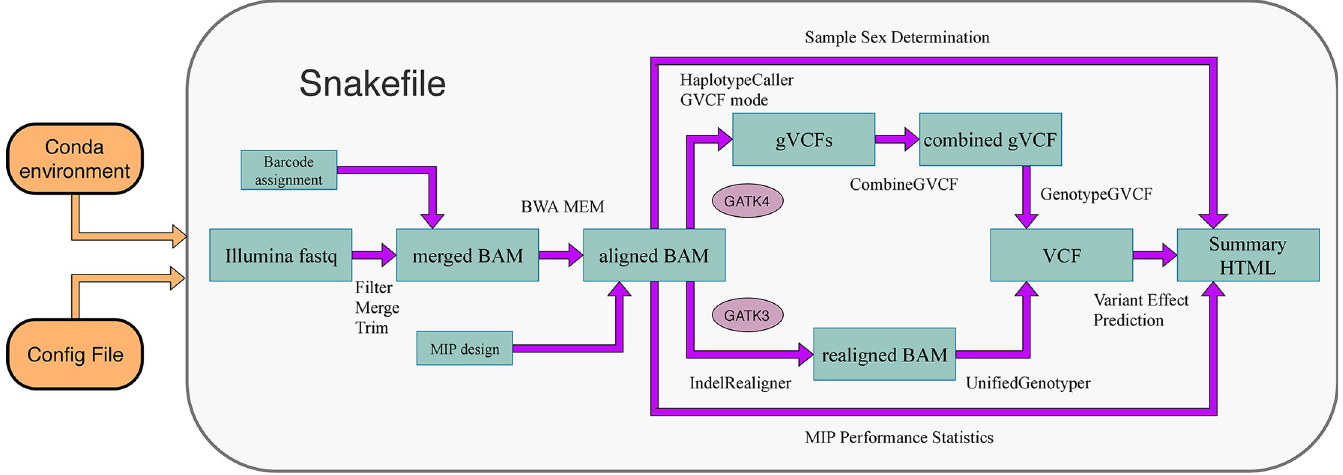
Fig 1. Depiction of analysis workflow of the hemoMIPs